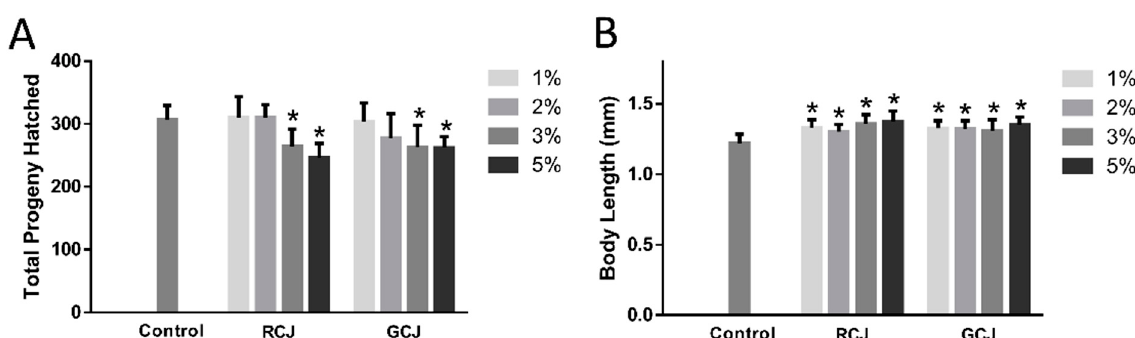
Figure 5. Effect of red cabbage juice (RCJ) and green cabbage juice (GCJ) on brood size ( A ) and body length ( B ) of C. elegans . ( A ) Synchronized L4 larvae were individually transferred to a fresh plate each day until reproduction ceased ( n = 10). ( B ) Synchronized L4 larvae worms were treated with RCJ and GCJ. Photographs were taken of animals on day 5, and the body length of each individual nematode was analyzed by Image J software ( n = 30). The images were taken at 100× magnification. Data are presented as mean ± SD. * p < 0.05 vs. control by one-way ANOVA followed by Bonferroni correction.